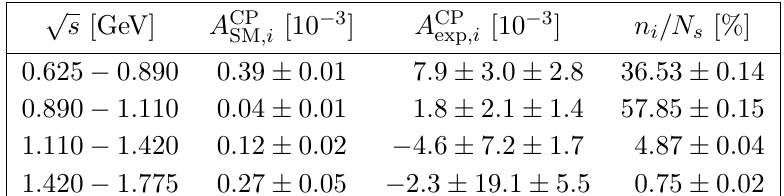
, as well as the observed number i